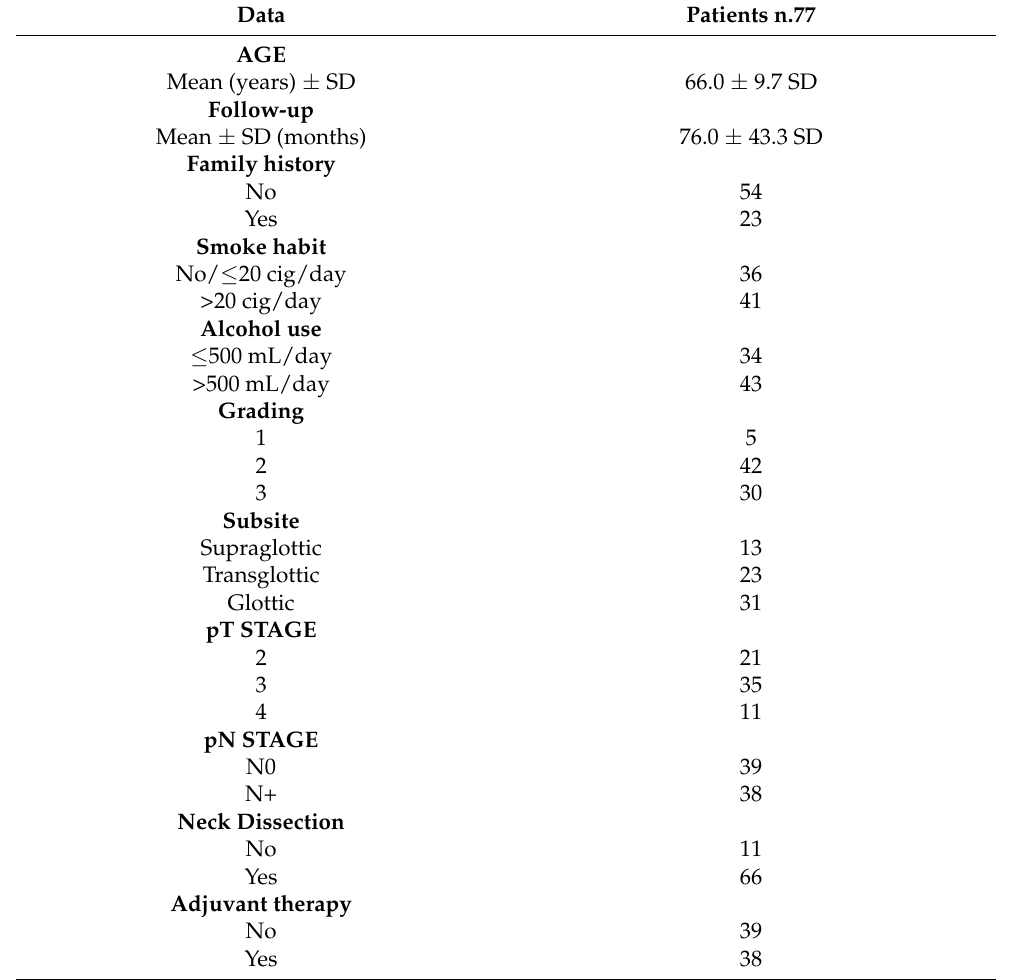
Table 1. Patients clinical-demographic data.